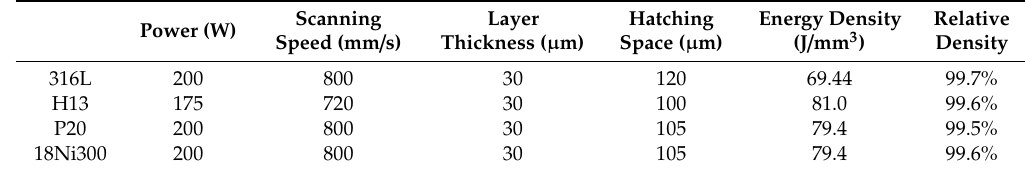
Table 3. Selective laser melting processing parameters for the four steel powders.